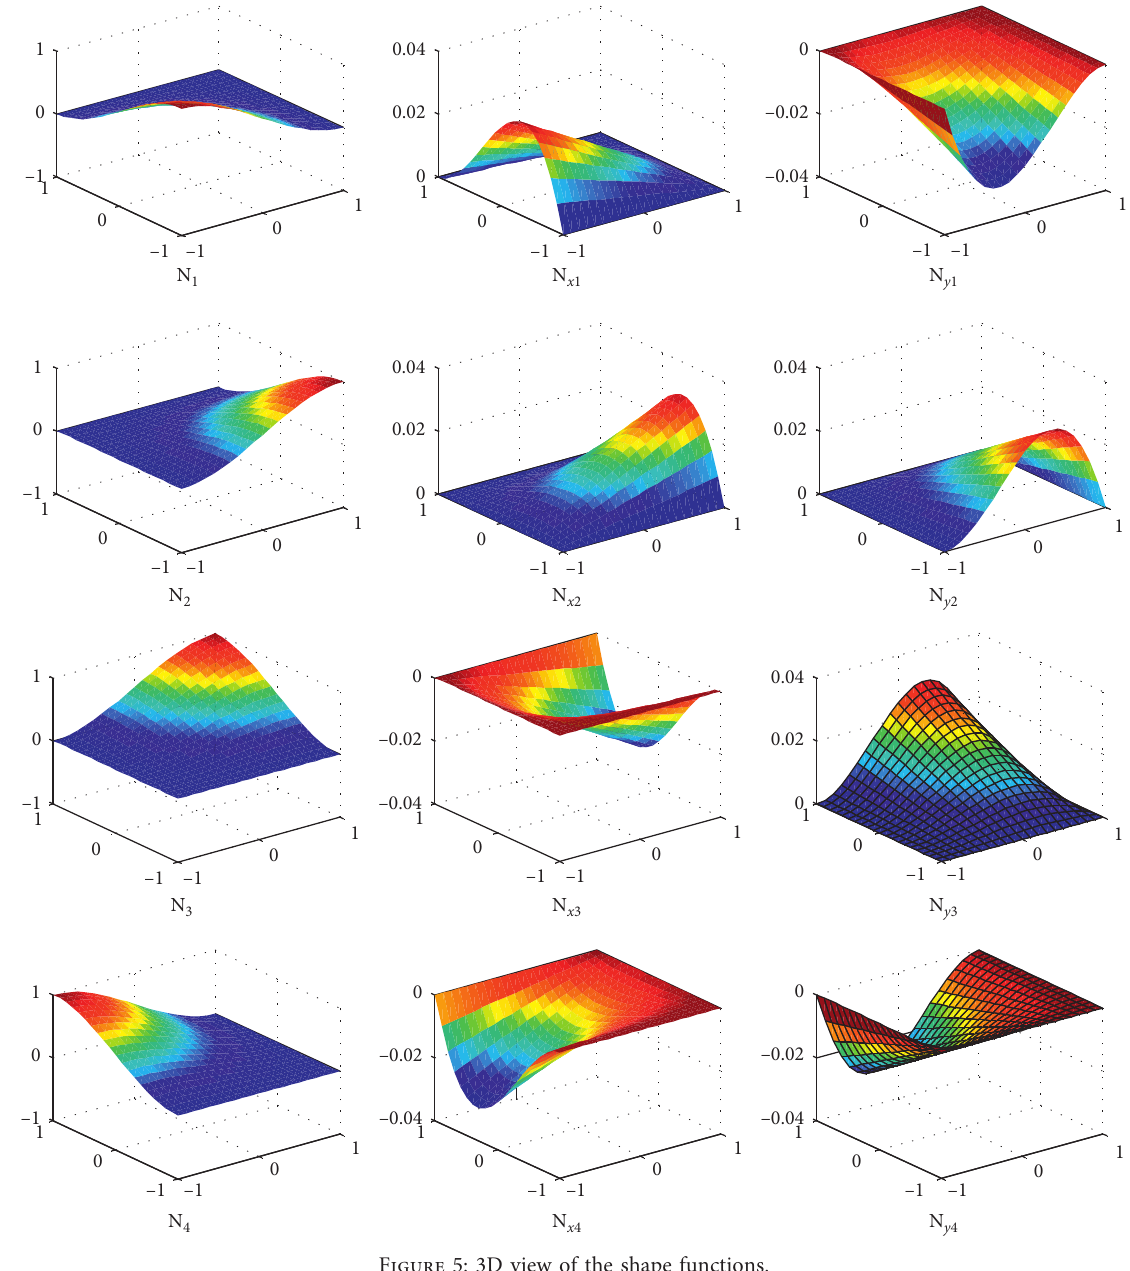
Figure 5: 3D view of the shape